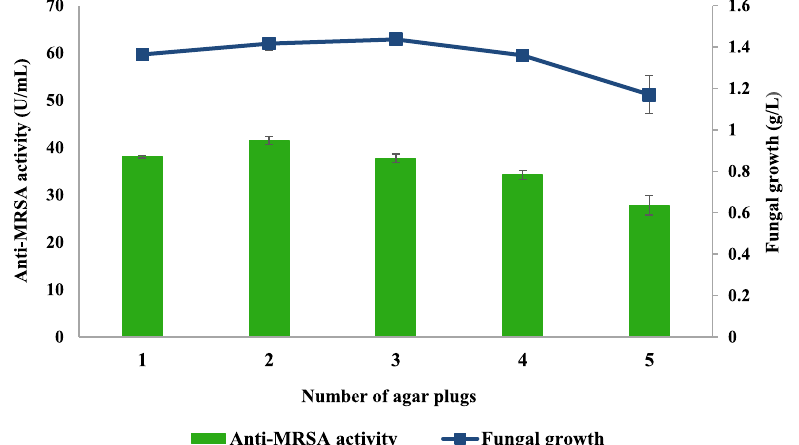
Fig. 6. Effects of the number of mycelial plugs on the production of anti-MRSA activity and fungal growth by L. pseudotheobromae IBRL OS-64. Different letters indicate significant differences between means (Duncan, p<0.05). Standard deviation values of triplicate analyses are shown by error bars.